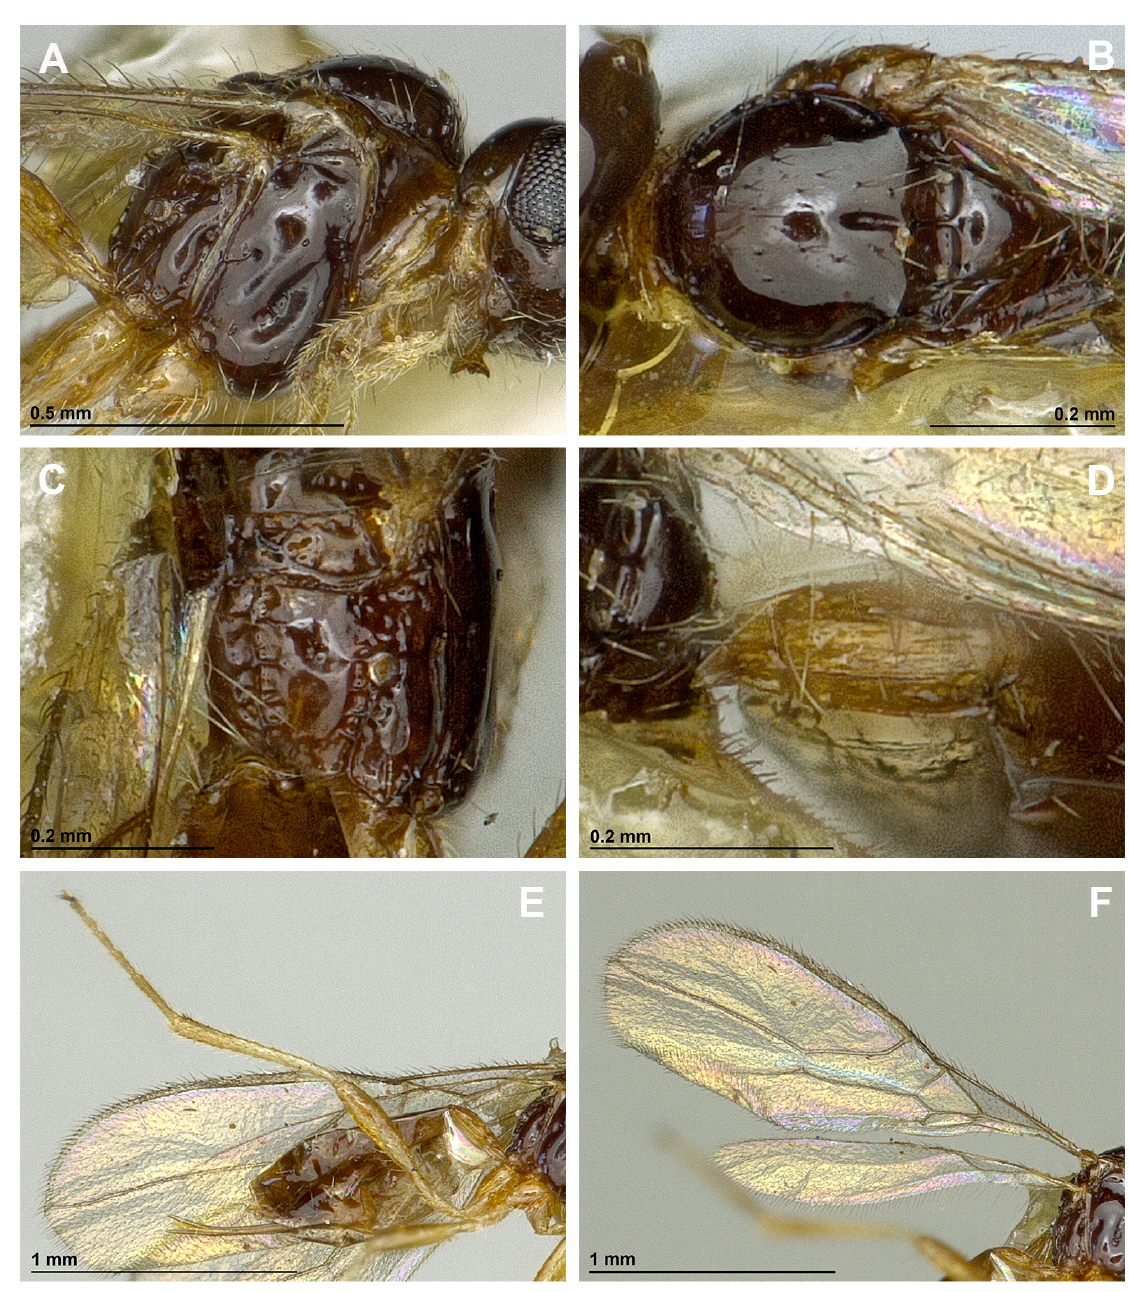
Fig. 11. Synaldis novateutoniae Peris-Felipo, sp. nov., ♀. A . Mesosoma, lateral view. B . Mesonotum, dorsal view. C . Propodeum. D . First metasomal tergite. E . Legs, metasoma and ovipositor, lateral view. F . Fore and hind